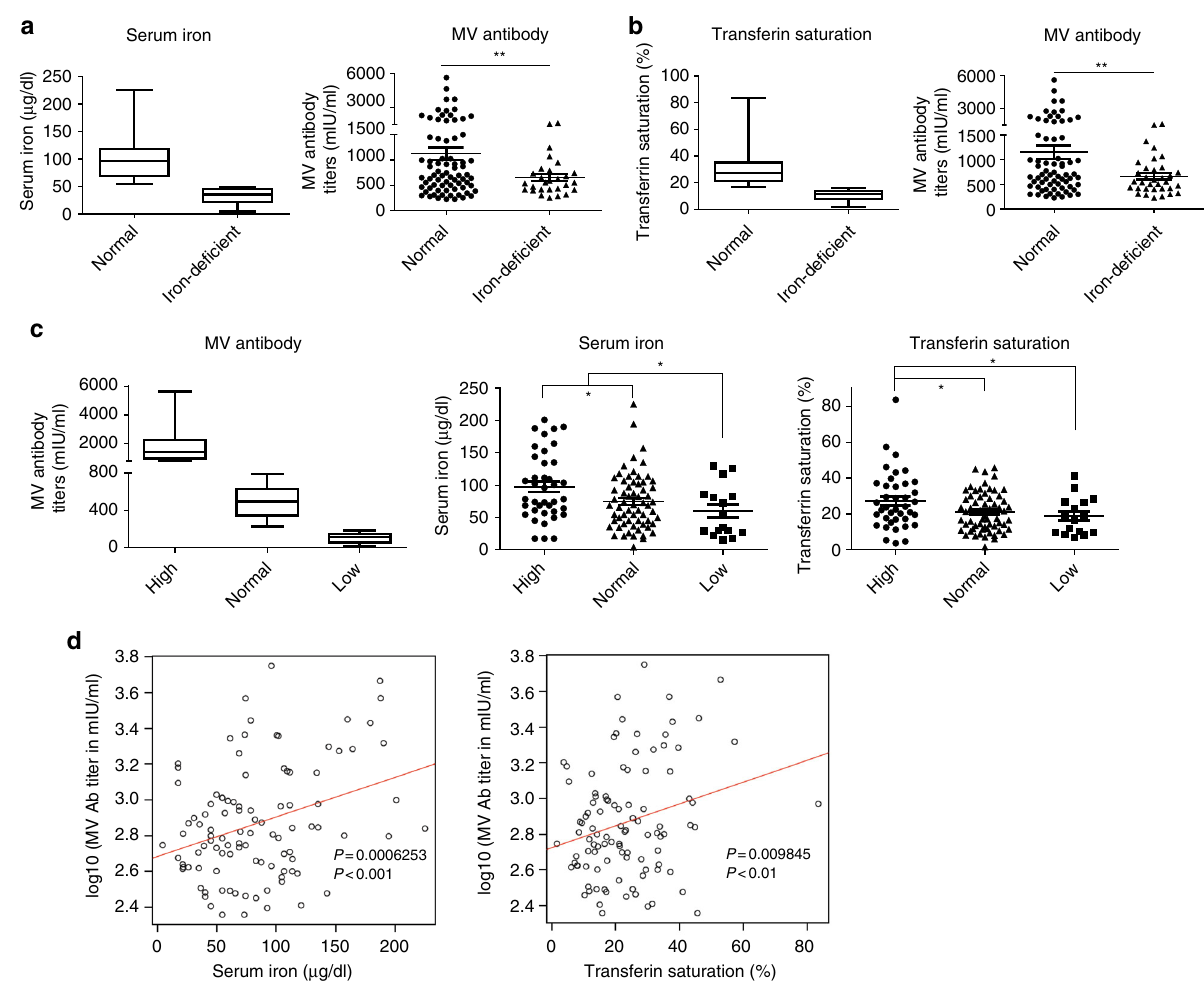
Fig. 1 MV response is positively correlated with iron metabolism indicators in humans. a , b MV-speci fi c IgG antibody titers in human patients with iron de fi ciency (de fi ned as serum iron < 50 μ g/dl or TS < 16%) vs . normal subjects. * P < 0.05, ** P < 0.01, Student ’ s t- test. c Serum iron levels and transferrin saturation in individuals with different degrees of MV response. * P < 0.05, ** P < 0.01, Student ’ s t- test. d A linear regression model was used to analyze the relationship between serum iron parameters (serum iron and TS) and MV concentrations in humans. The scatter-plot graphs with error bars indicate the mean ± SEM, and the box and whisker graphs with error bars indicate the range from the minimum value to the maximum